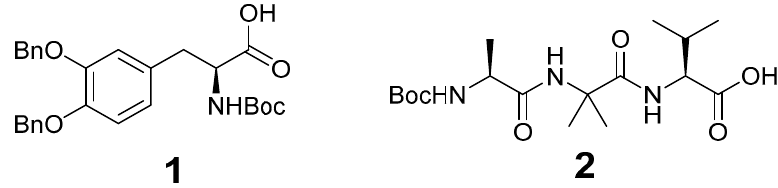
Figure 1. Chemical structure of the peptide gelators described in this work.